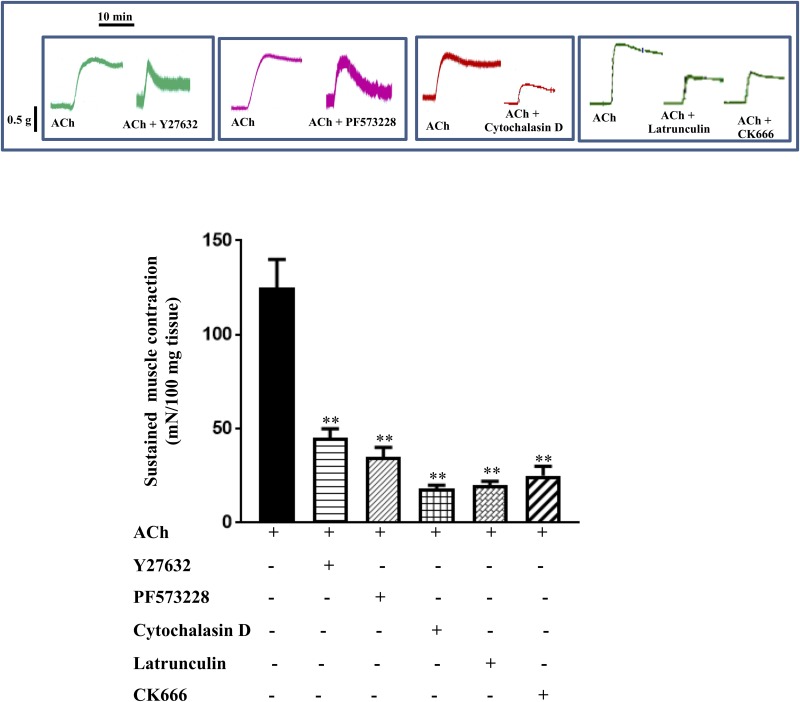
Inhibition of sustained actin polymerization prevents ACh-induced sustained smooth muscle contraction in muscle strips.Muscle contraction was measured as increase in sustained contraction in response to acetylcholine (10 μM) in organ bath experiments in gastric smooth muscle of mice in the presence or absence of Rho kinase inhibitor Y27632 (10 μM, 10 min), FAK inhibitor PF573228 (10 μM, 1 h) or Arp2/3 inhibitor CK-666 (200 μM, 1h), actin polymerization inhibitors (cytochalasin D, 10 μM; latrunculin, 1 μM, 1 h). Results are expressed as mN/100 mg of tissue. Traces are included in the graph. Values are means ± SE of 4–6 experiments. **P<0.001.